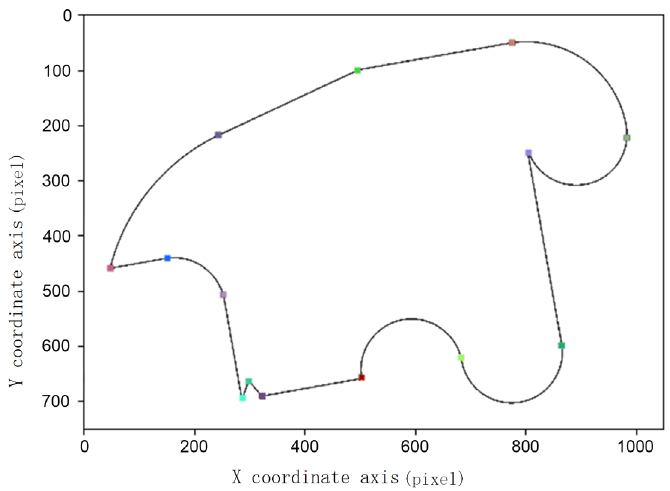
Figure 18. Results for selected segmentation points on image to be tested.